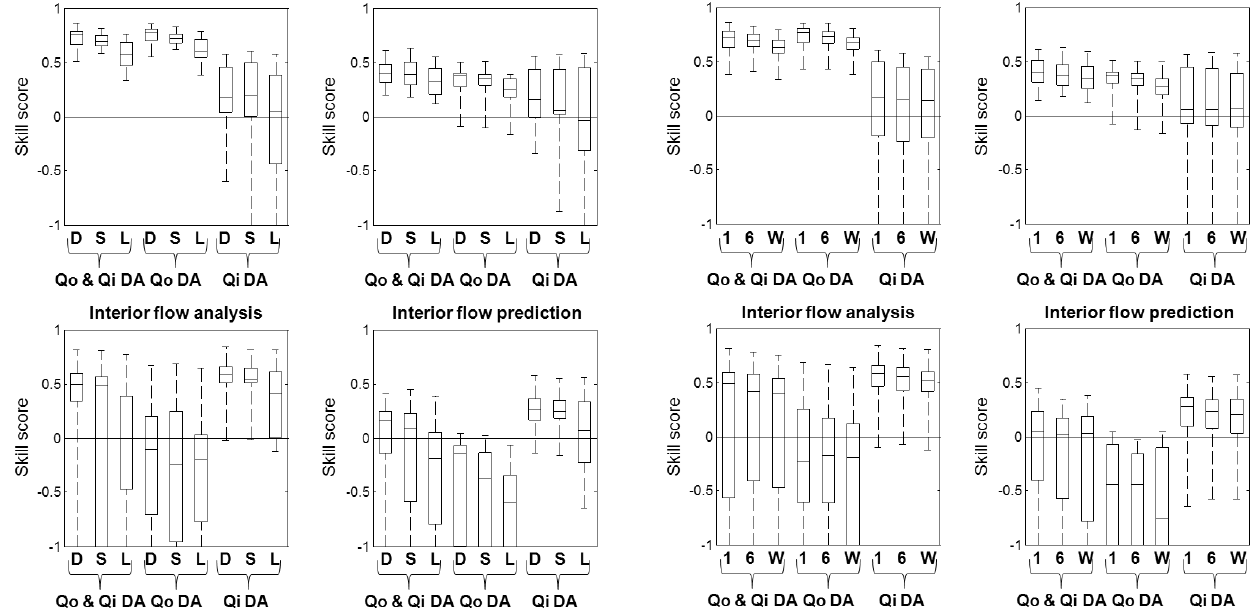
Fig. 7. Mean skill score vs. spatial adjustment scale where the mean skill score is obtained by averaging mean squared error-based skill score calculated for individual event. Mean skill score for the pre- diction period is calculated using streamflow predicted for 1- to 6-h lead time. In the above, D, S, and L denote distributed, semi- distributed and lumped ways of adjusting the SAC-states, respec- tively; Qo&Qi DA, Qo DA and Qi DA denote both outlet and in- terior flow assimilation, outlet flow assimilation and interior flow assimilation, respectively.